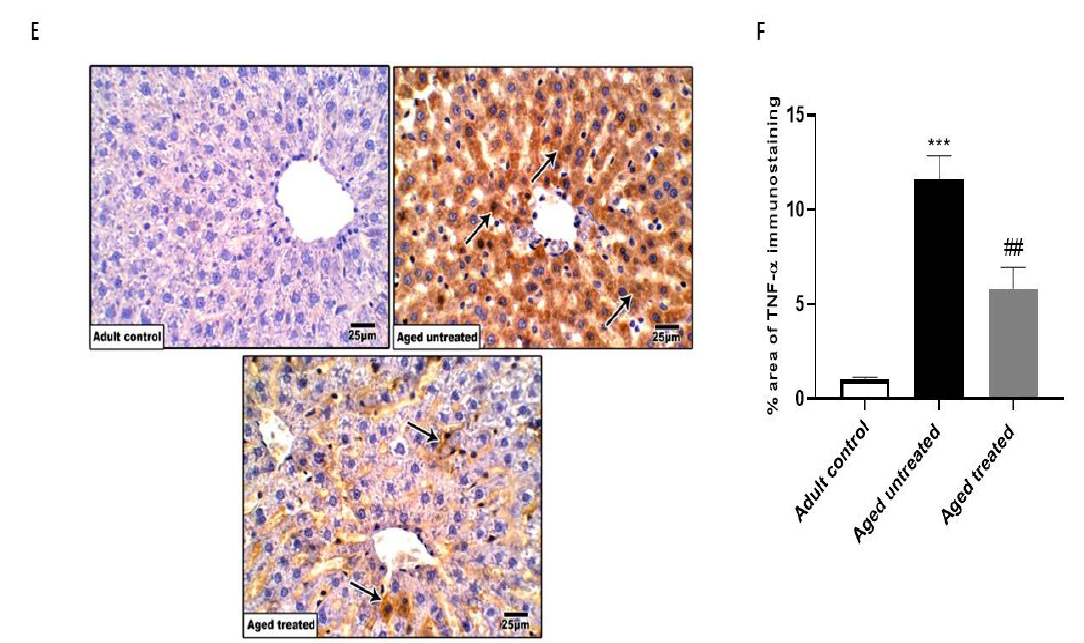
Figure 5. Effect of VK2 administration on hepatic inflammation. ( A ) Hepatic COX-2 immunostaining. ( B ) Quantitative assessment of the % area of hepatic COX-2 immunostaining, ( C ) hepatic iNOS immunostaining, ( D ) quantitative assessment of the % area of hepatic iNOS immunostaining, ( E ) hepatic TNF- α immunostaining and ( F ) quantitative assessment of the % area of hepatic TNF- α immunostaining. Values are expressed as the mean ± SE, n = 6. ** p < 0.01 and *** p < 0.001 compared to the Adult control group. # p < 0.05, ## p < 0.01 and ### p < 0.001 compared to the Aged untreated group.